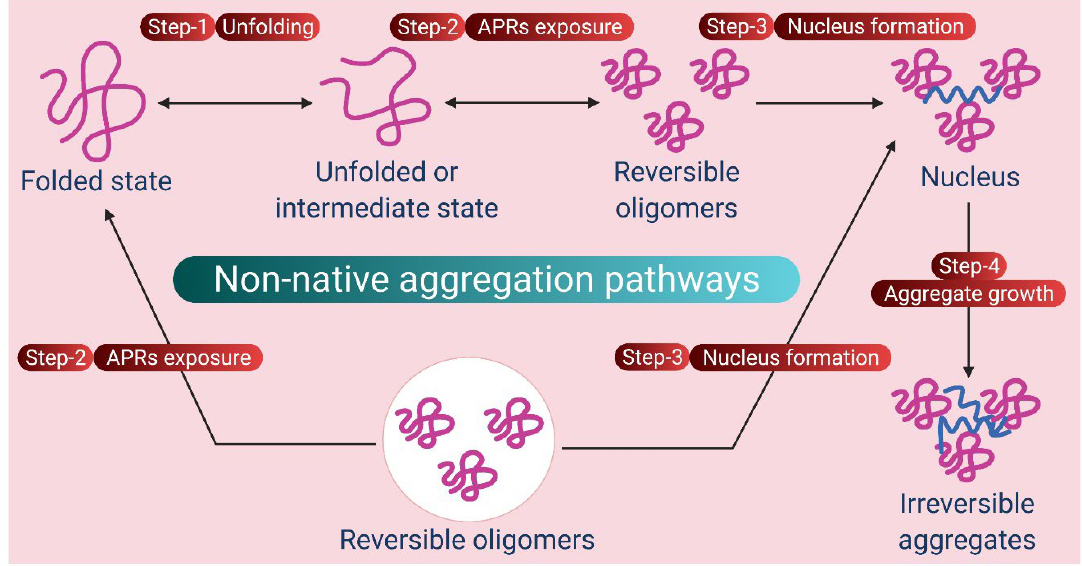
Figure 3: Overview of non-native protein aggregation pathways. APRs, aggregation prone